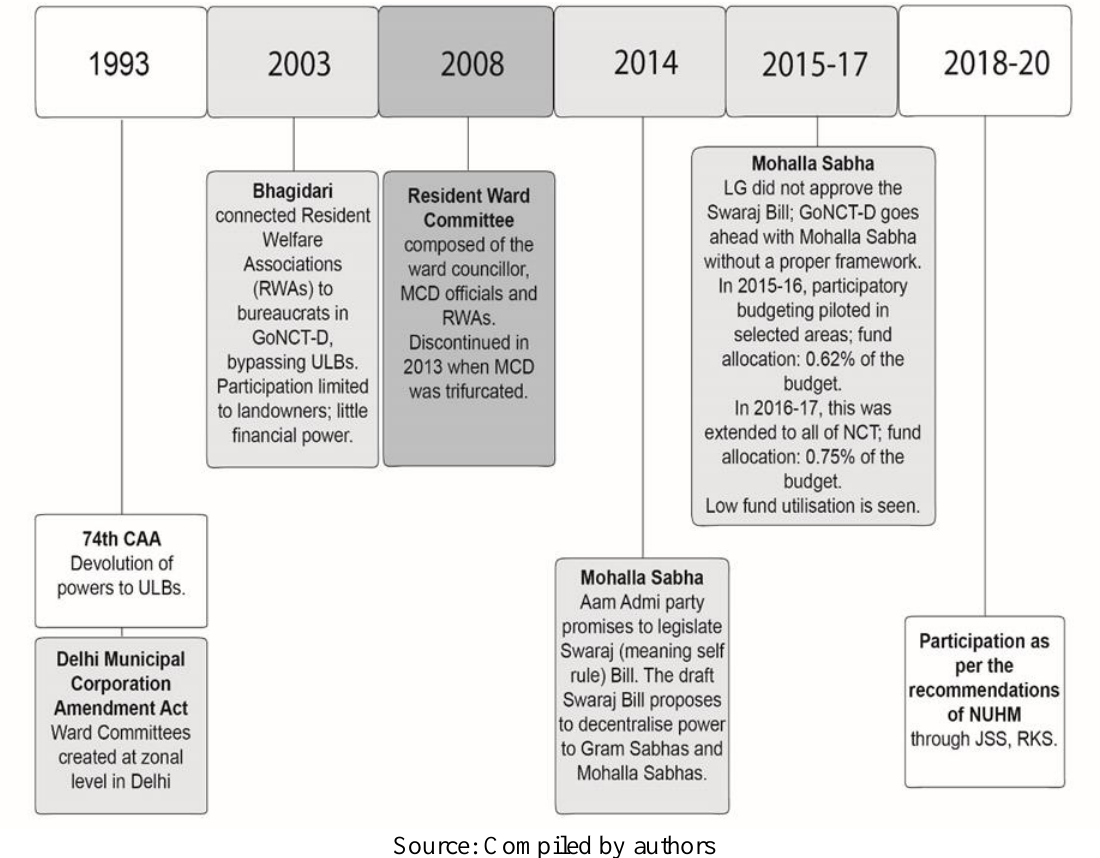
Source: Compiled by